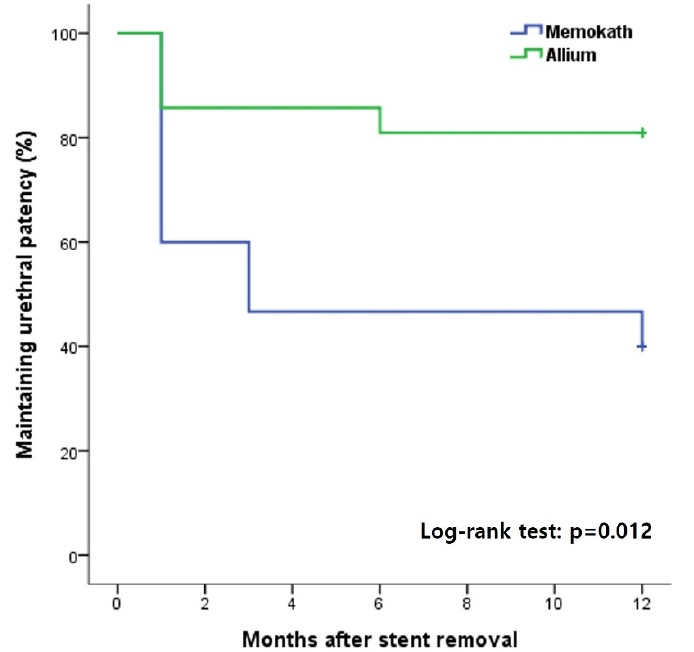
Figure 3. Kaplan–Meier curves for overall success rate by stent type over 12 months after stent removal.